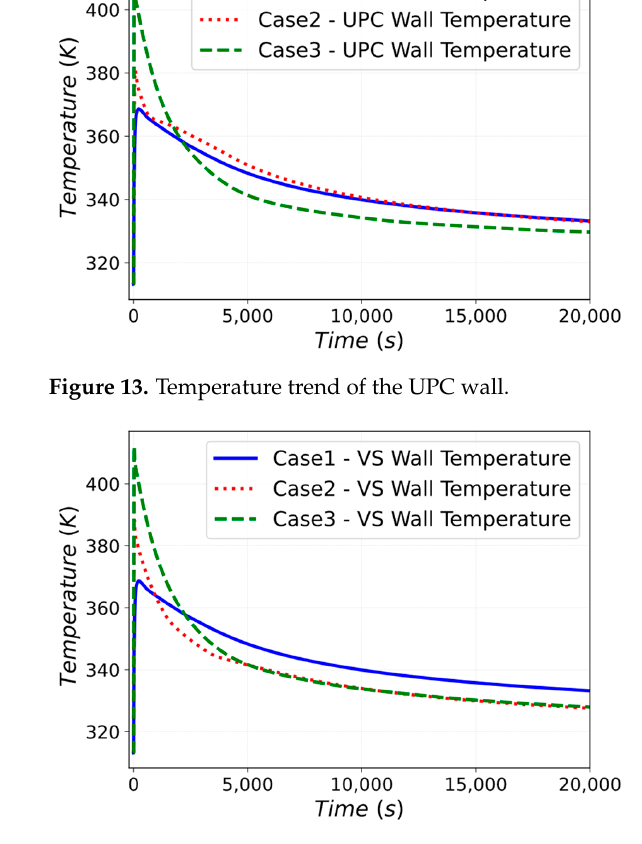
Figure 14. Temperature trend of the VS wall.